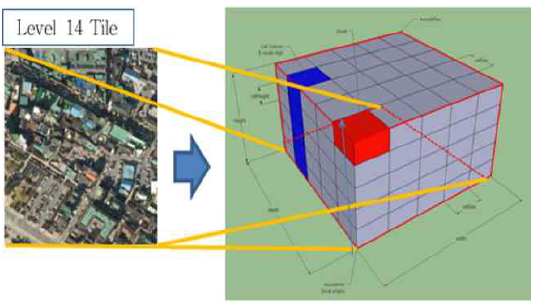
Figure 8. Concept of a grid in a 3D tile